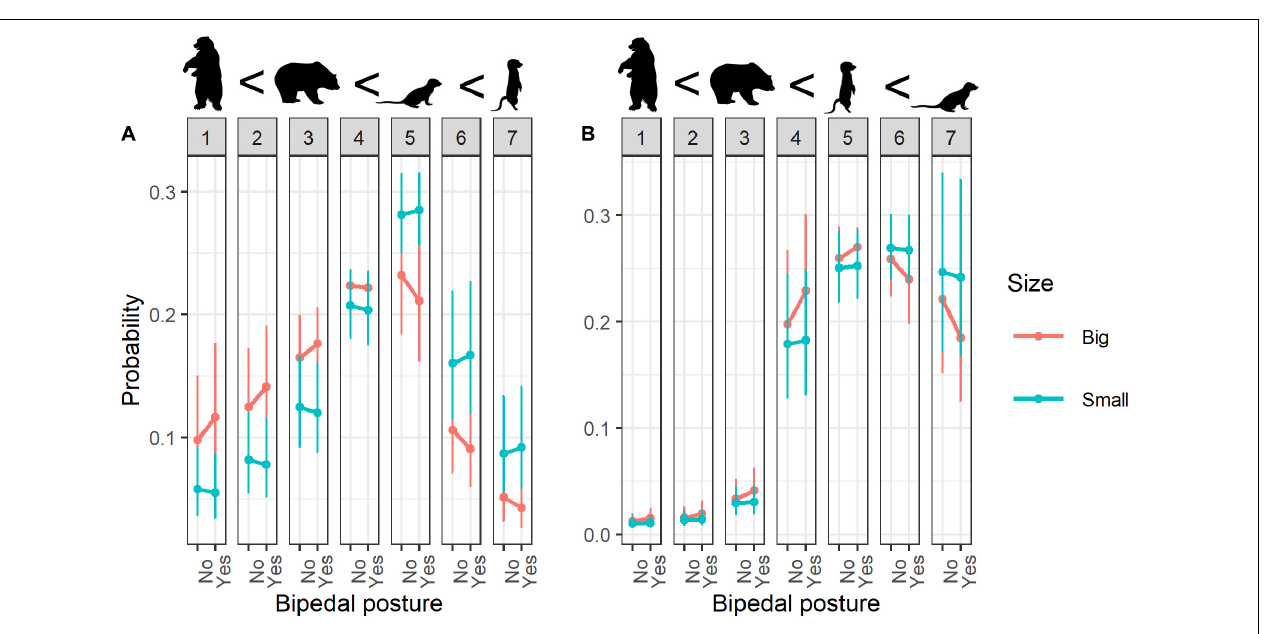
FIGURE 2 | Interaction effects of Bipedal posture:Size for (A) cuteness, (B) willingness to protection. Error bars indicate 95% confidence interval; numbers 1–7 refer to rating